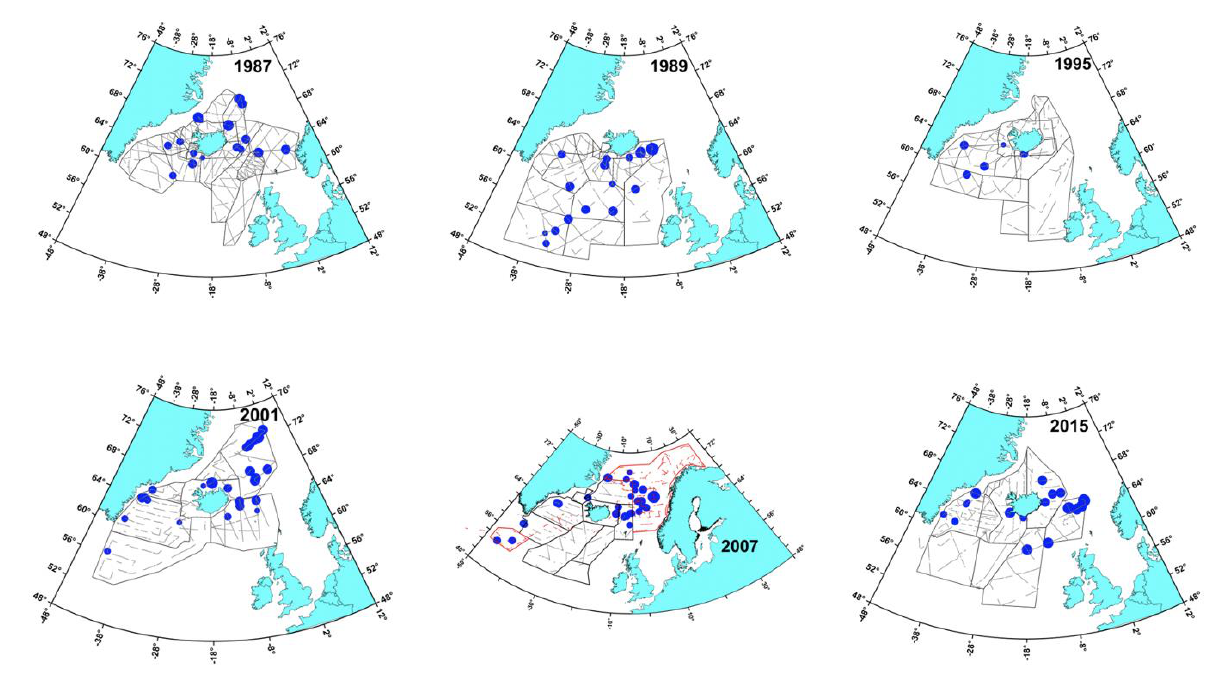
Figure 3. Realized survey effort (BSS<5) and sightings of killer whales. Symbol size varies with group size from 1 to